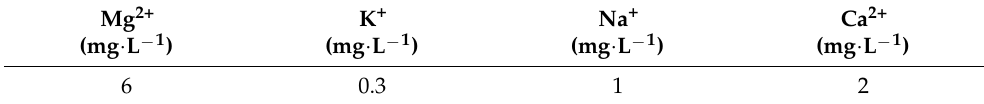
Table 2. Concentrations of ions in the exhausted loading solution determined by